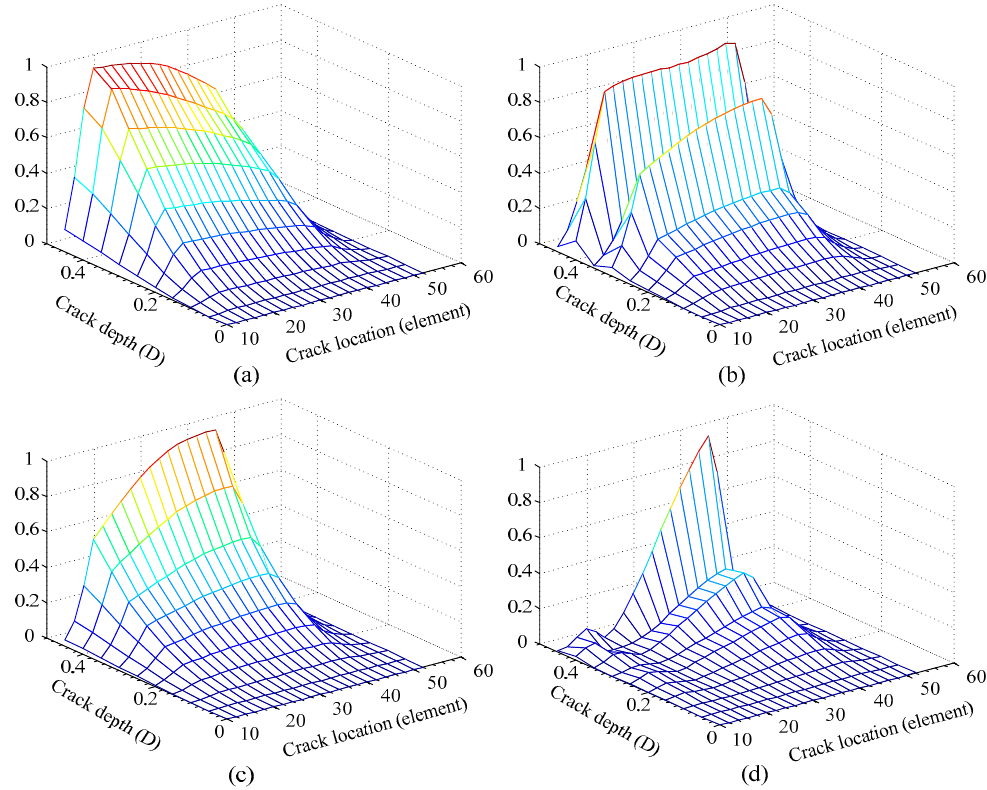
Figure 5. Normalized amplitudes of super-harmonic components with different crack locations and depths ( a ) 2 × at 1/3 critical rotating speed; ( b ) 3 × at 1/3 critical rotating speed; ( c ) 2 × at 1/2 critical rotating speed; ( d ) 3 × at 1/2 critical rotating speed.